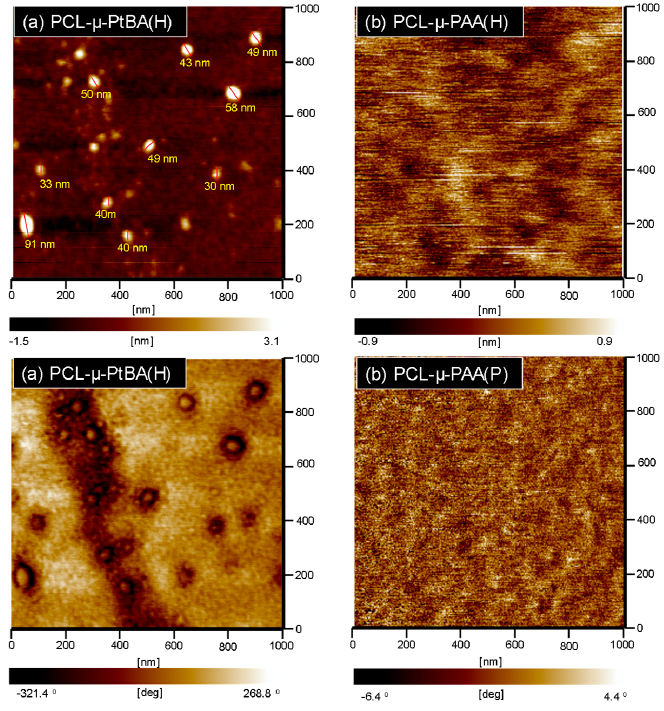
Figure 10. AFM images of ( a ) PCL- μ -PtBA and ( b ) PCL- μ -PAA star copolymers (H: height and P: phase). Polymers 2018 , 8 , x